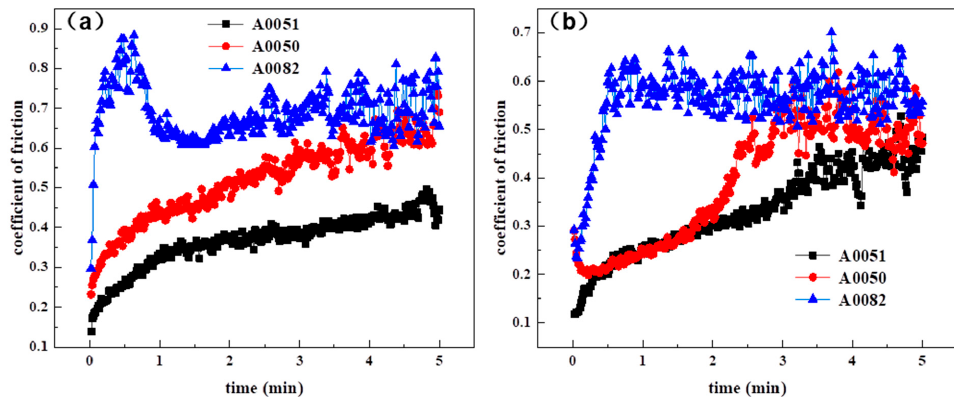
Figure 5. Variation of friction coefficient with time under different friction frequencies: ( a ) 2 Hz; ( b ) 3 Hz.